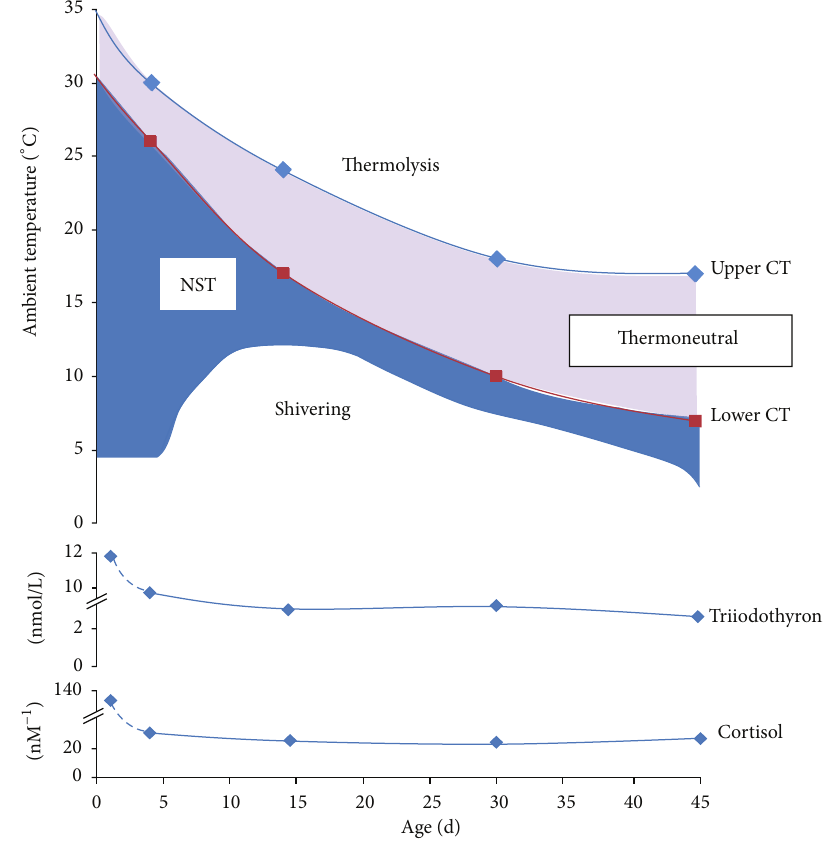
Figure 1: Summary of the metabolic and endocrine changes that occur from birth to 45 days of postnatal life in the sheep as brown adipose tissue is lost and shivering replaces nonshivering thermogenesis (NST) as the primary response to cool exposure. Adapted from Symonds et al. [104]. CT: critical